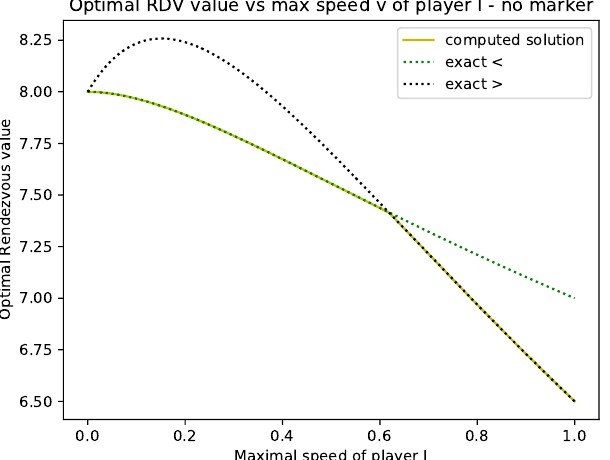
Figure 2. Plot of the solution of the rendezvous problem vs. the maximum speed of player I. The computed solution is a plot a 1001 points evaluated at n /1000, n ∈ [ 0,1000 ] . The exact solution has √ √ two algebraic forms for v < ( 5 − 1 ) /2 (exactl<, (13)) or v > ( 5 − 1 ) /2 (exact >, (14)).